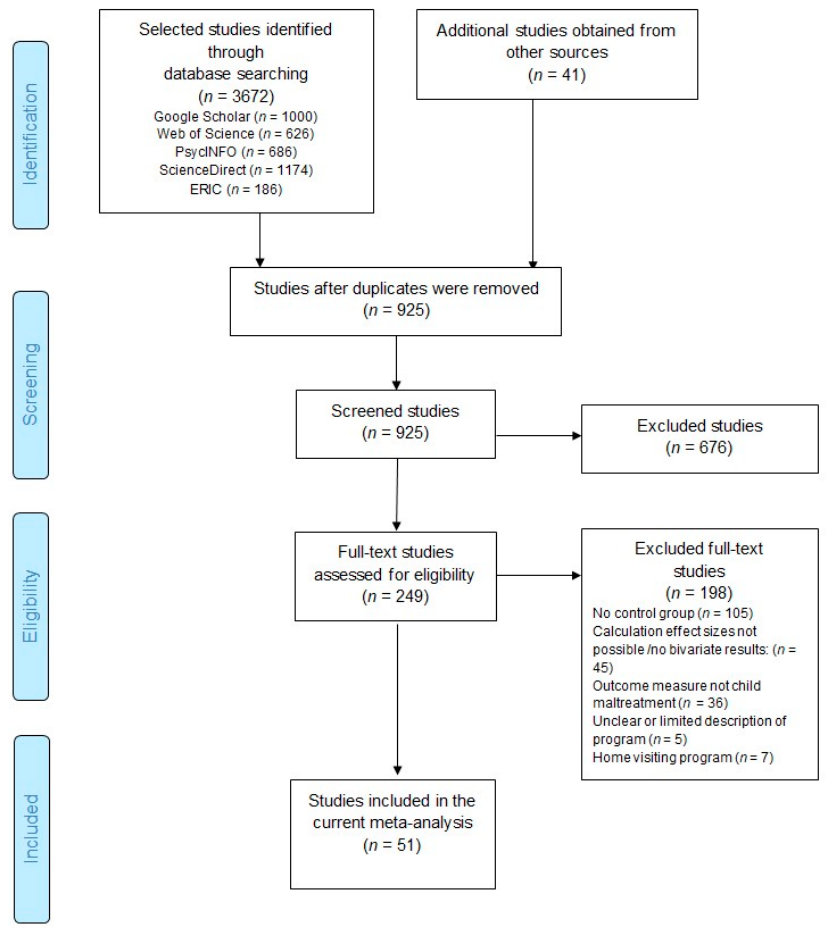
Figure 1. Flowchart of study selection procedure, according to the Preferred Reporting Items for Systematic Review and Meta-Analysis (PRISMA).